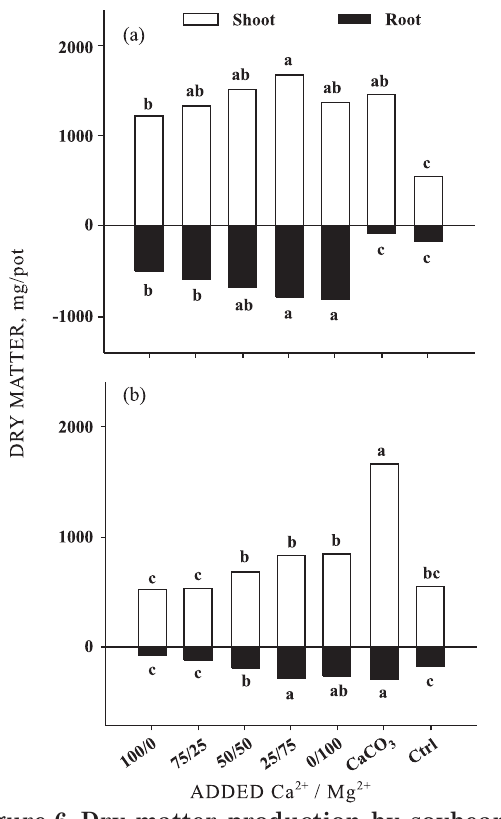
Figure 6. Dry matter production by soybean